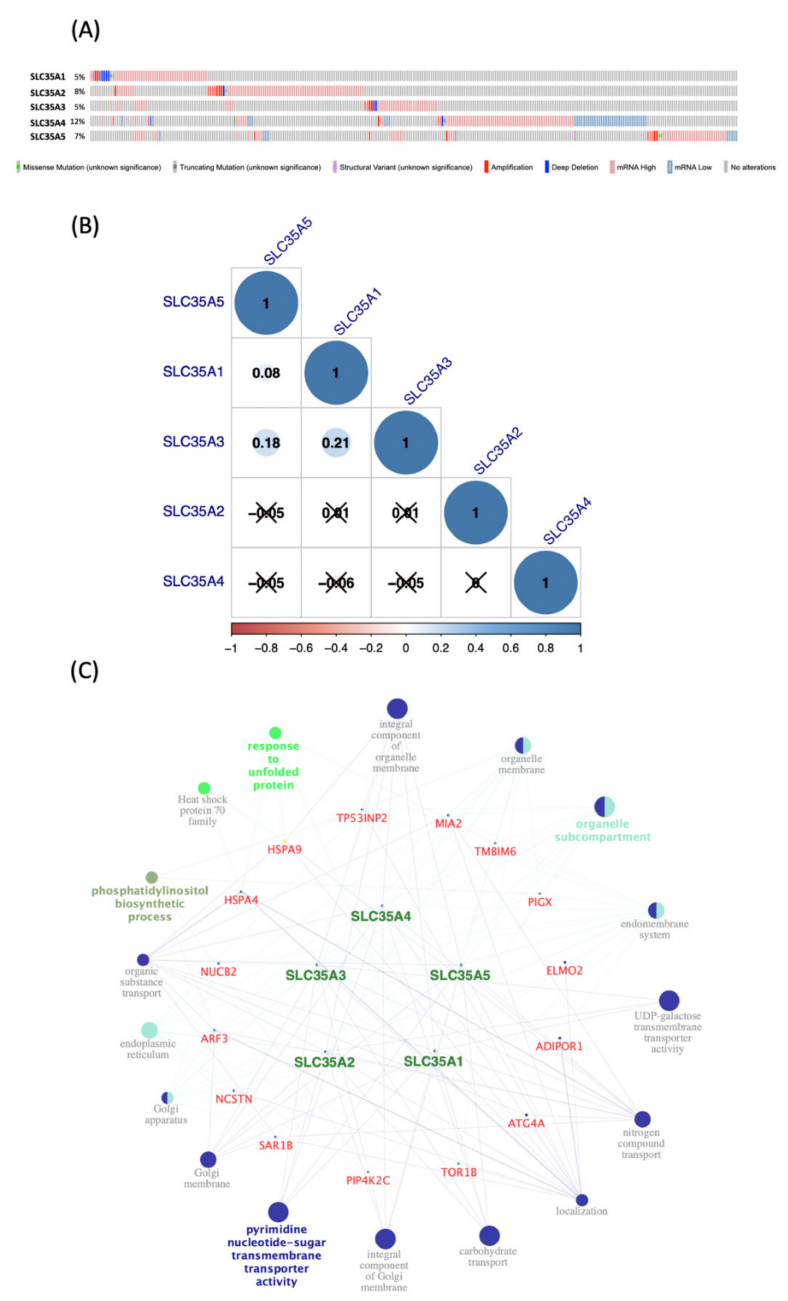
Figure 5. Co-expression analysis and genetic alterations in solute carrier 35A (SLC35A) family members (cBioPortal) (Cytoscape). ( A ) Alterations in SLC35As in TCGA Pan-Cancer Atlas ( n = 1082), are summarized. Gene amplification is represented by red bars, deep deletions by blue bars, and missense mutations by green bars. This graph demonstrates that SLC35A2 (8%) and SLC35A4 (12%) have substantial rates of mutation. ( B ) Using the TCGA Pan-Cancer Atlas dataset ( n = 1082), correlations among SLC35A family members in breast cancer were assessed. The “corrplot” R package was used to build the symmetrical correlation matrix. Color of Spearman’s rank correlation coefficients (rho) indicate the degree of pairwise correlations (rho). A positive correlation is indicated by a darker blue tone and a larger dot size, whereas a negative correlation is indicated by a darker red color and a smaller dot size. Non-significant correlation coefficient values ( p > 0.01) are represented by a cross symbol. ( C ) A network of connected genes and pathways was created. For each SLC35A member, top 20% of co-expressed genes were shorlisted from the METABRIC database